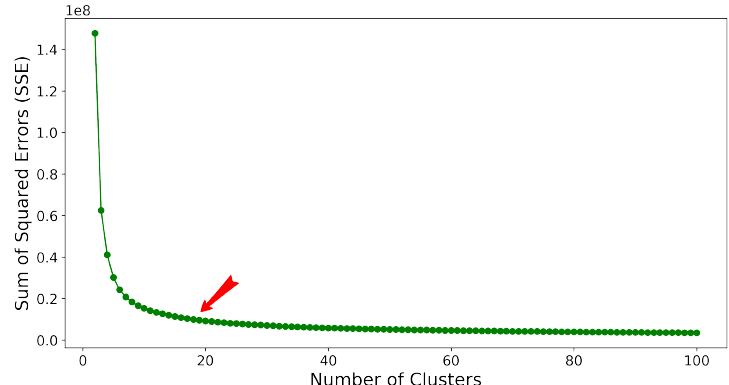
Figure 2. The sum-of-squared errors (SSE) is plotted as a function of the number of clusters k identified via k-means on structures generated via HEA on a target protein. This target is part of our evaluation dataset related in Section 3. Specifically, it is the target protein with known native structure in the PDB entry with identifier (id) 1ail. The red arrow points to the knee/elbow region where by increasing k SSE does not change noticeably; this is the region from where an optimal value of k can be selected.